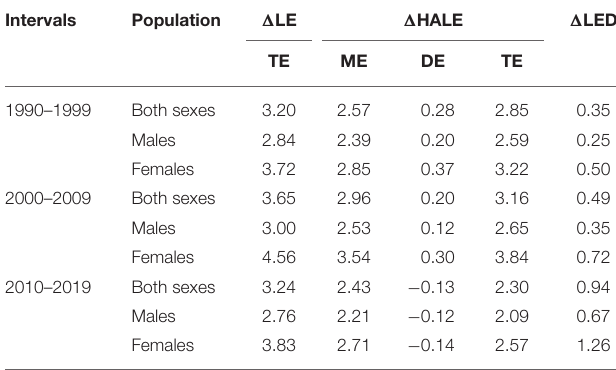
TABLE 2 | Effects of mortality and disability on changes in life expectancy (LE) and health-adjusted life expectancy (HALE) (years) for 10-year interval.